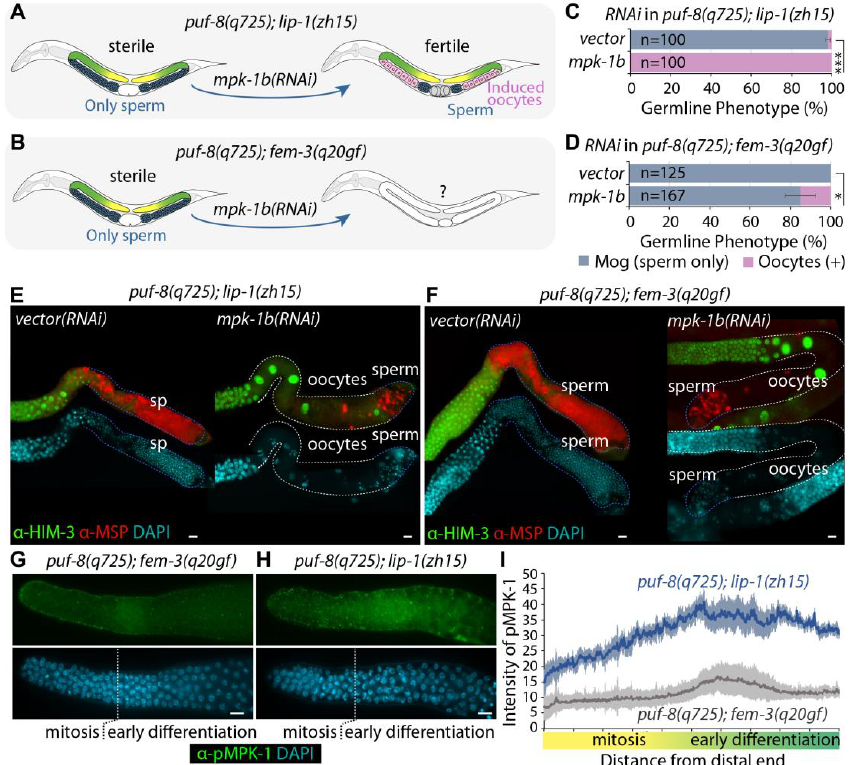
Figure 4. MPK-1B dependence of puf-8(q725) ; lip-1(zh15) and puf-8(q725) ; fem-3(q20gf) Mog pheno- types. ( A ) MPK-1B dependence of puf-8(q725) ; lip-1(zh15) Mog sterility. ( B ) The potential role of mpk-1b in puf-8(q725) ; fem-3(q20gf) Mog sterility. ( C , D ) mpk-1b RNAi completely rescues puf-8(q725) ; lip-1(zh15) Mog sterility, but partially rescues puf-8(q725) ; fem-3(q20gf) Mog sterility. All experiments were performed in triplicate. The statistical significance was assessed by Student’s t -test without corrections for multiple comparisons. ***, p < 0.001; *, p < 0.05; ns, not statistically significant. ( E , F ) Germline staining with anti- HIM-3 and anti-MSP antibodies. Scale bars are 10 µ m. ( G , H ) Germline staining with anti-DP-MAPK monoclonal antibody and DAPI. Germlines (4 days past L1) were treated identically, and images were taken with the same settings at the same magnification for comparison. Scale bars are 10 µ m. ( I ) Quantitation of pMPK-1 proteins in puf-8(q725) ; fem-3(q20gf) ( n = 15) and puf-8(q725) ; lip-1(zh15) ( n = 15) mutant germlines. The intensity of pMPK-1 proteins was quantified using ImageJ software. The x -axis represents the distance from the distal end of the germline, and the y -axis is pixel intensity. Error bars are standard